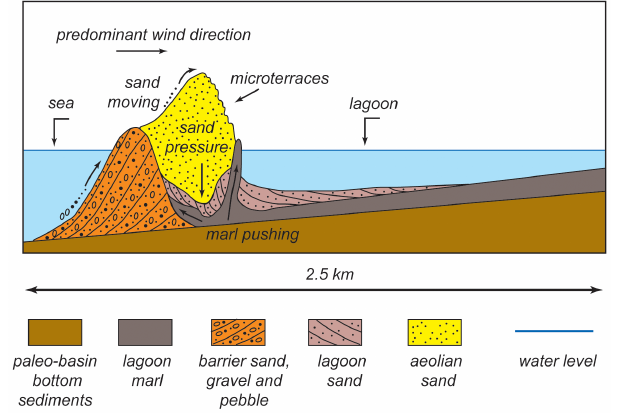
Figure 4. Lagoon marl layer deformation model in the investigated area (by Sergeev et al.,